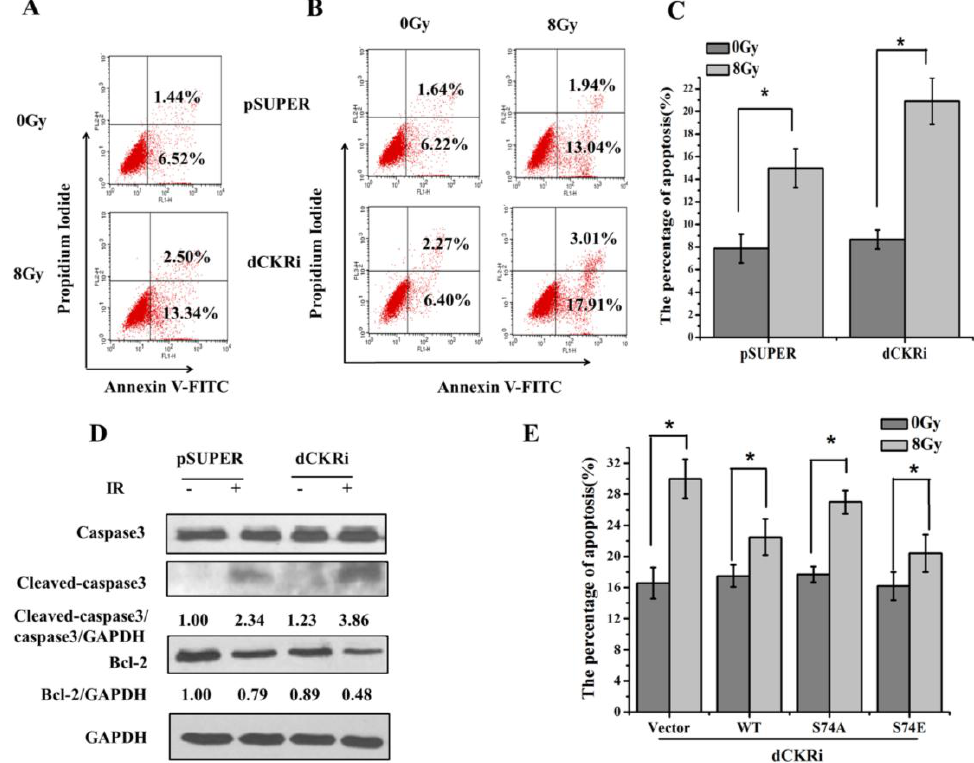
Figure 2. dCK silencing promoted IR-induced apoptosis. ( A ) Flow cytometry was used to quantify apoptosis in HeLa cells 24 h after radiation. Cells were stained with propidium iodide (PI) and Annexin V-FITC. The positive-stained cells were counted using FACScan; ( B ) apoptosis was detected in